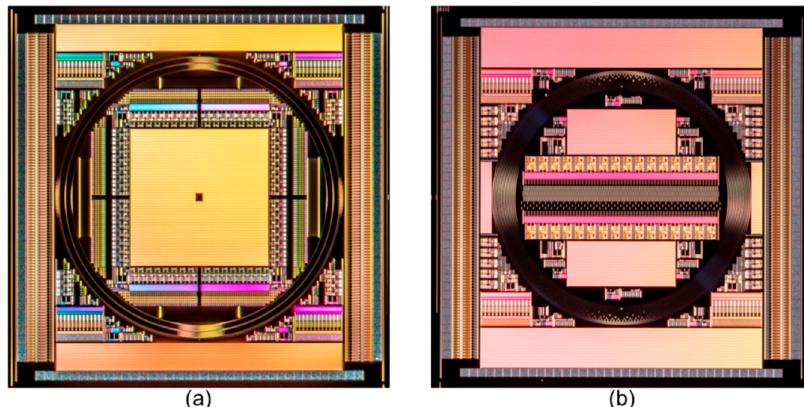
Figure 14. Microscope images of the opto-ASICs. ( a ) Opto-ASIC with segmented photodiodes; ( b ) opto-ASIC with Gray code photodiode structure.